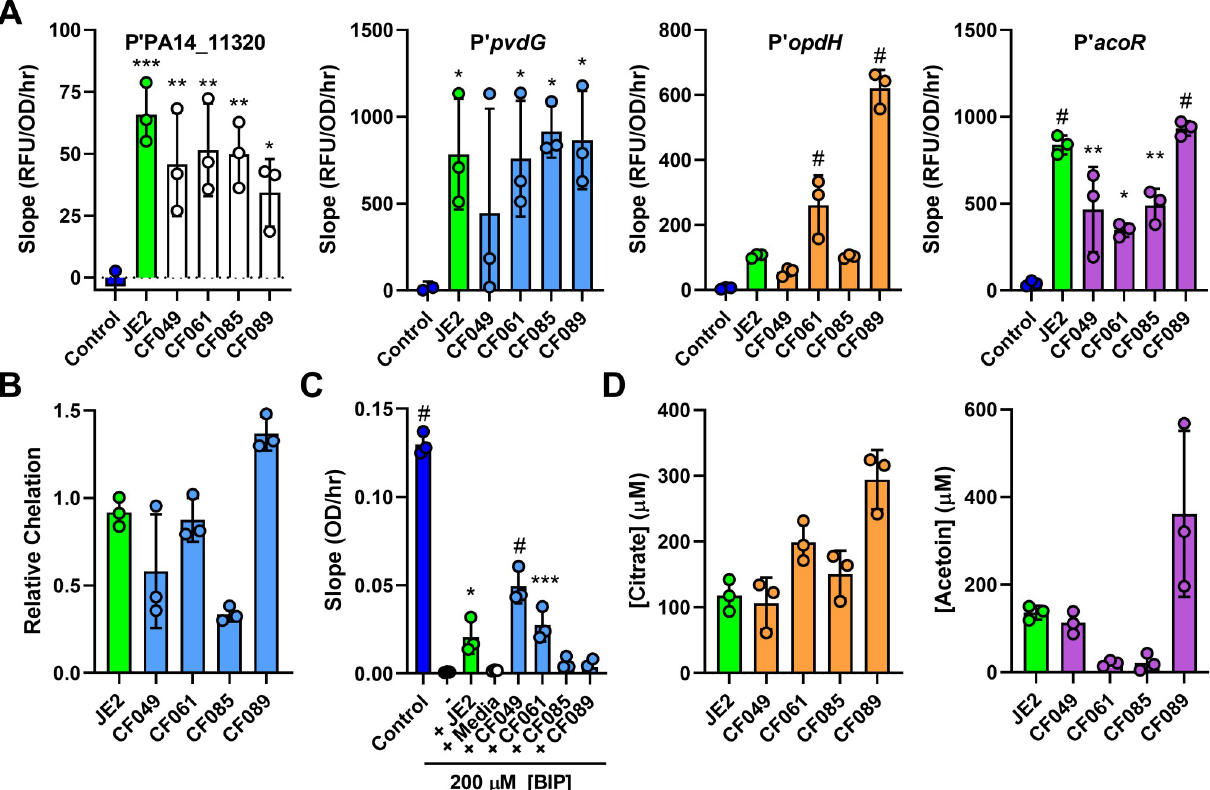
Fig 7. Sensed exoproducts are secreted by S . aureus clinical isolates. (A) RFU of mScarlet normalized to OD 600 over time (promoter of PA14_11320, opdH , and acoR calculated from 1.5 to 5 hours; promoter of pvdG calculated from 1 to 4 hours) of the indicated promoter-reporter strains after exposure to media control, or supernatants from S . aureus JE2 or clinical isolates CF049, CF061, CF085, and CF089. (B) Relative chelation of supernatants collected from S . aureus JE2 or the indicated clinical isolate. (C) Slope of OD 600 over time from 1 to 8 hours of P . aeruginosa Δ pvdJ Δ pchE strain in medium control or medium with 200 μ M BIP with the addition of medium or supernatant from S . aureus JE2 or the indicated clinical isolate. (D) Citrate and acetoin measurements of supernatants collected from S . aureus JE2 or the indicated clinical isolates. For panels A and C, datasets were analyzed by 1-way ANOVA with Dunnett test for multiple comparisons to the media only control for A and no addition for C. Three independent replicates shown for all panels. Error bars denote the SD. � , p < 0.05; �� , p < 0.01; ��� , p < 0.001; #, p < 0.0001. The data underlying all panels can be found in S1 Table. RFU, relative fluorescence unit; SD, standard